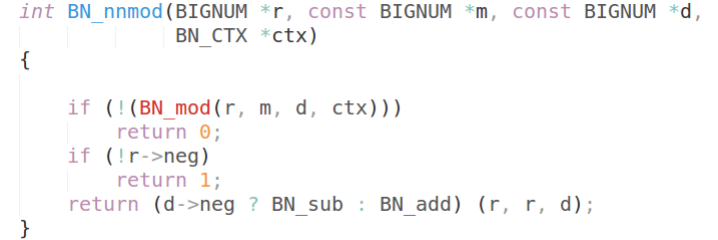
Figure 10: Code snippets for the function BN_nnmod in